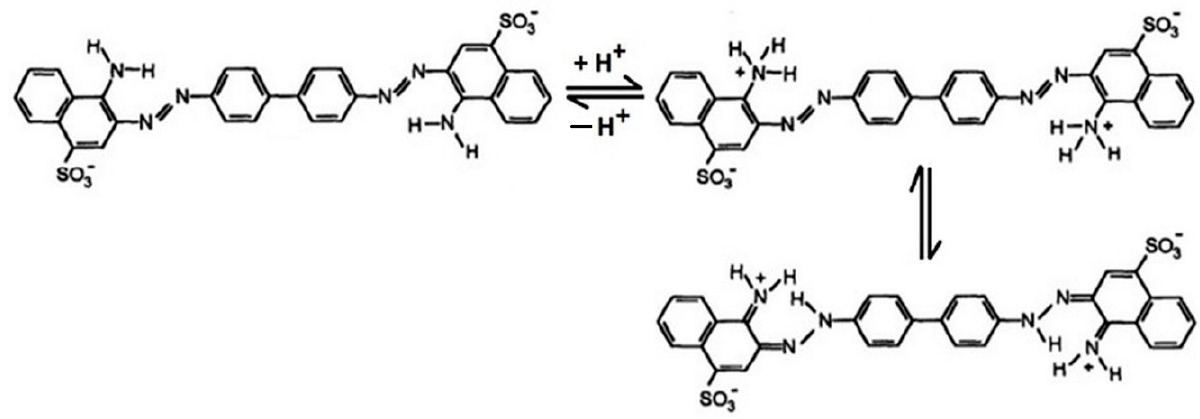
Figure 10. The Congo Red structures in acidic solution [39].